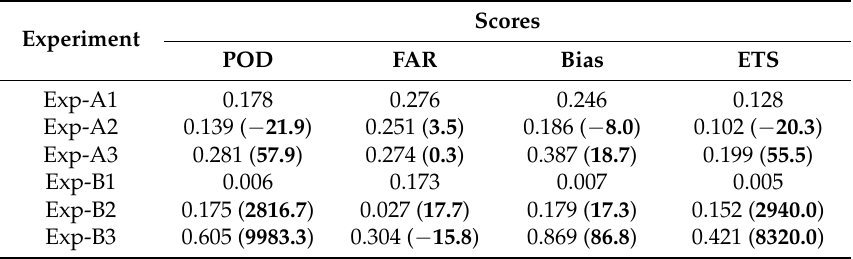
Table 5. Statistical results of the experiments. The improvements (%) in Exp-A2 and Exp-A3 relative to Exp-A1 are in parentheses and set in boldface, as well as Exp-B2 and Exp-B3 relative to Exp-B1. Scores Experiment